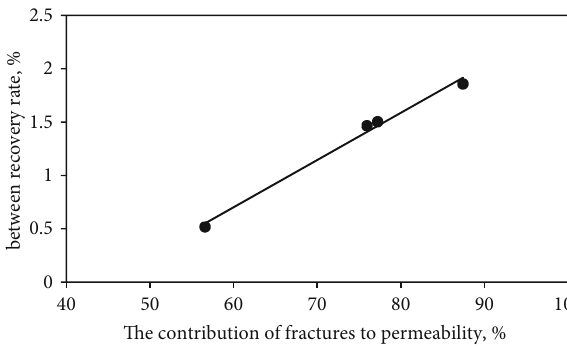
Figure 11: Di ff erential recovery of prefractured and fractured cores where water cut rises from 95% to